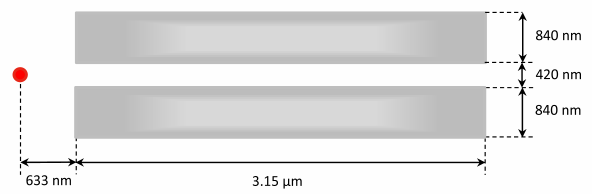
Figure 7: Line source located next to a plasmonic waveg- uide consisting of two silver strips.